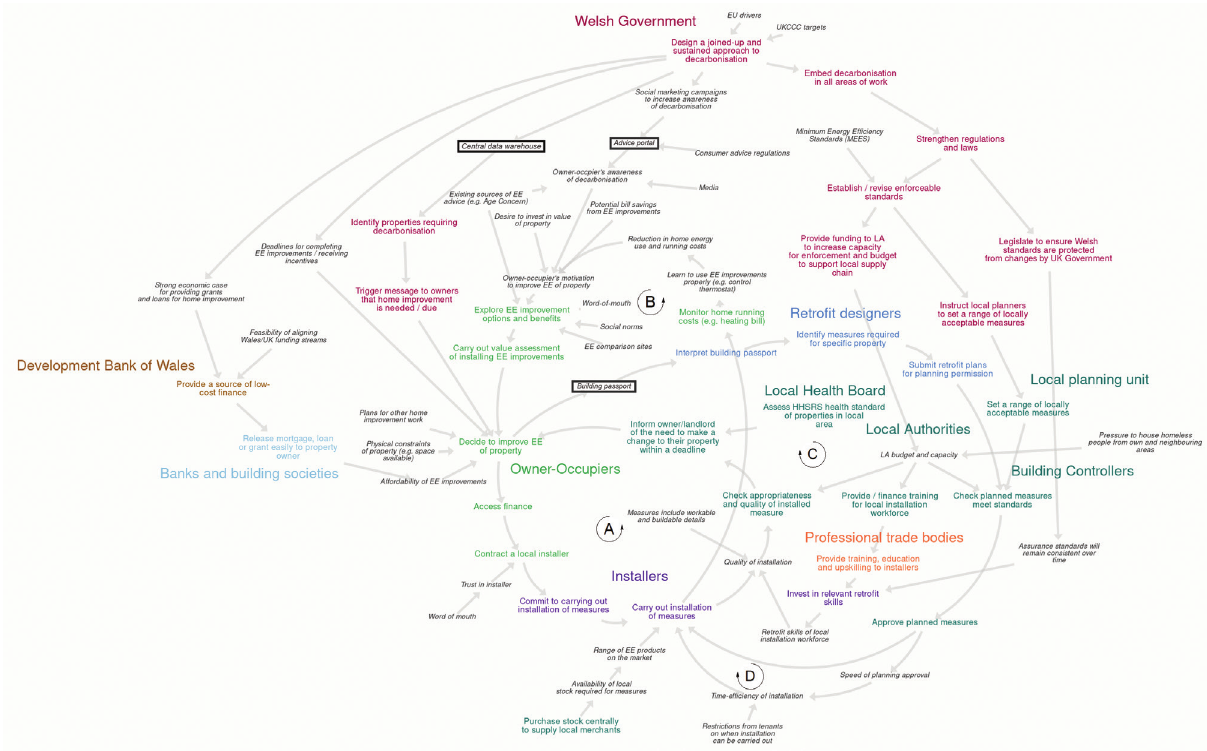
Behavioural systems map for owner- occupiers. Note. This figure shows a qualitative BSM for the system of decarbonising homes owned by owner-occupiers. The map represents the system ‘as it could be’, meaning that it reflects the reality of the current system, but it also includes behaviours and influences that could be put in place to support retrofit at scale. Actors are shown in large bold text. Behaviours are shown in medium bold text. Influences on behaviour are shown in small italic text. Colour coding is used to show which actors perform which behaviours. Arrows are used to show positive causal links identified among behaviours and influences on behaviour. Black text boxes are used to show potential new services or resources identified to support decarbonisation. Abbreviations: EE, energy efficiency/ energy efficient; HHSRS, housing health and safety rating system; LA, local authority; MEES, minimum energy efficiency